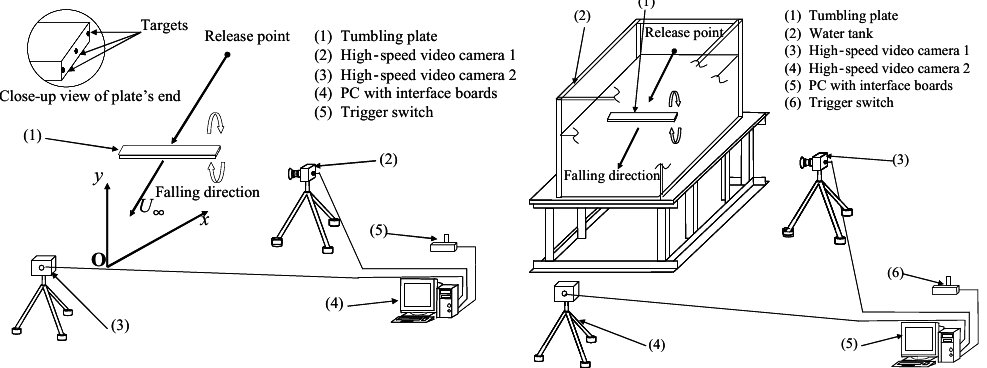
Fig. 4 Experimental apparatus in